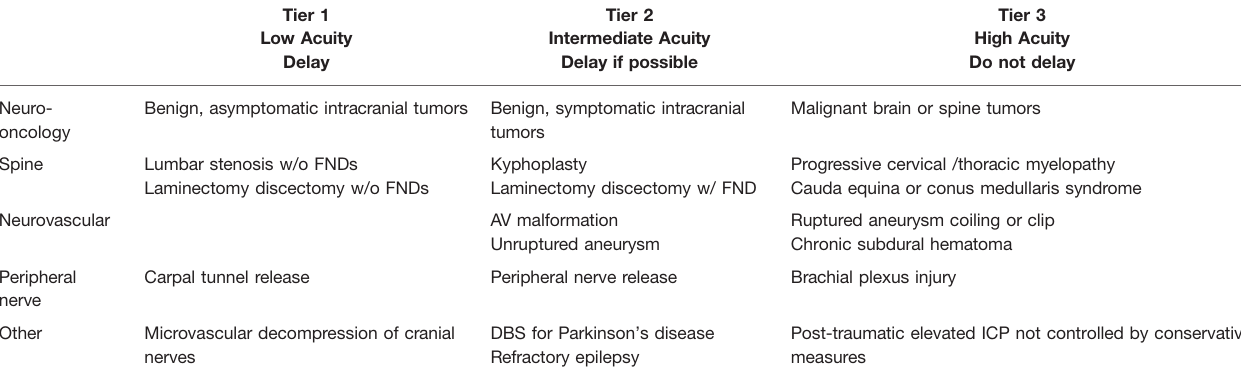
TABLE 5 | Neurosurgery Elective Surgery Acuity Scale (ESAS). All candidates for surgery should be assessed for surgical fi tness on an individual basis. This is an example ESAS and not comprehensive. Procedure acuity for the individual patient may shift among tiers based upon acuity of illness, severity of COVID-19 infection and coagulopathy, and hospital surgical capacity (135, 139). For speci fi c length of operative delay, please see the text and Association of Anesthesiologists guidelines